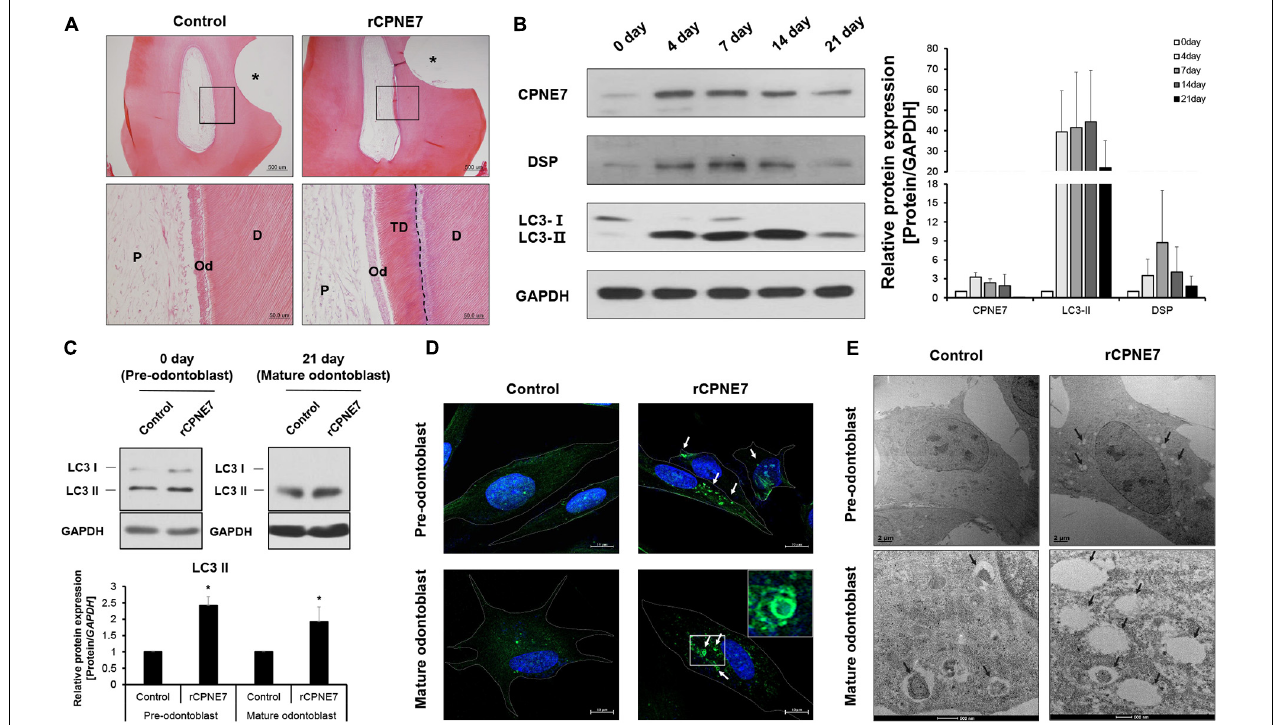
FIGURE 1 | CPNE7 induces autophagic activity in both pre-odontoblasts and mature odontoblasts. (A) Histological analysis of beagle dog pre-molar defect model. Scale bars = 500 µ m. The asterisk shows the tooth defect area. Boxed areas are shown at higher magnification. Scale bars = 50 µ m. The dotted line shows the boundary of tubular dentin newly formed from native dentin. (B) Western blot analyzing the protein expression patterns of CPNE7, LC3, and DSP in primary human dental pulp cells (hDPCs) during odontogenic differentiation. (C–E) Autophagic activity was analyzed in control and rCPNE7-treated hDPCs at the pre-odontoblast stage (day 0) and the mature odontoblast stage (day 21). (C) LC3 II protein levels were evaluated by western blotting. (D) Representative immunofluorescence images of LC3 (green dot; white arrows). DAPI (blue) counterstaining indicates the nucleus. Scale bars = 10 µ m. Boxed areas are shown at higher magnification. (E) Autophagic vacuoles (black arrows) were observed by transmission electron microscopy. Scale bars = 500 nm. hDPCs were treated with rCPNE7 (100ng/ml) for 24 h. CPNE7, copine-7; rCPNE7, recombinant CPNE7; P, pulp; Od, odontoblast; D, dentin; TD, tubular dentin; LC3, microtubule-associated protein 1A/1B-light chain 3; DSP, dentin sialoprotein. Significant differences are shown with asterisks. * P <